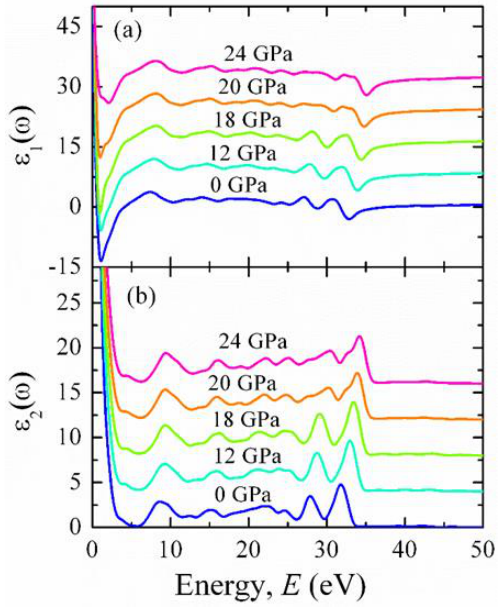
Figure 14. The energy dependence of the ( a ) real and ( b ) imaginary part of the dielectric constant of BaCuO 3 at some selected pressures. Different offset values are set to visualize the optical spectra clearly.